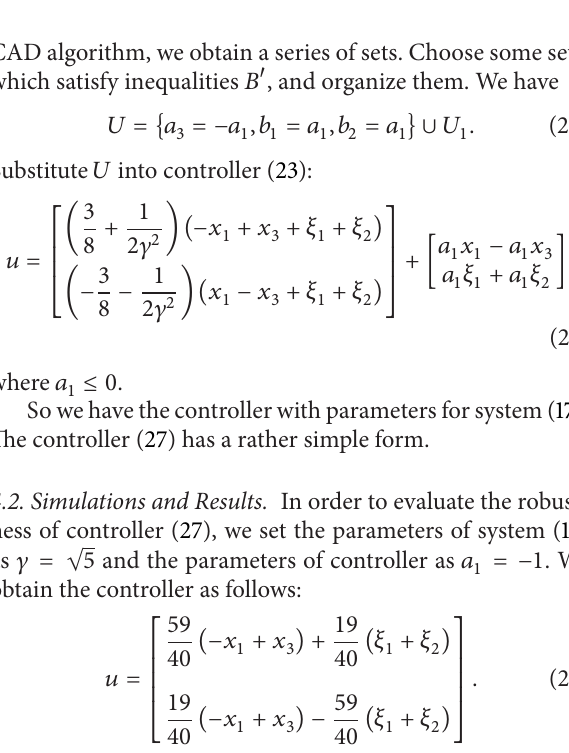
Figure 1: Swing curves of 𝑥